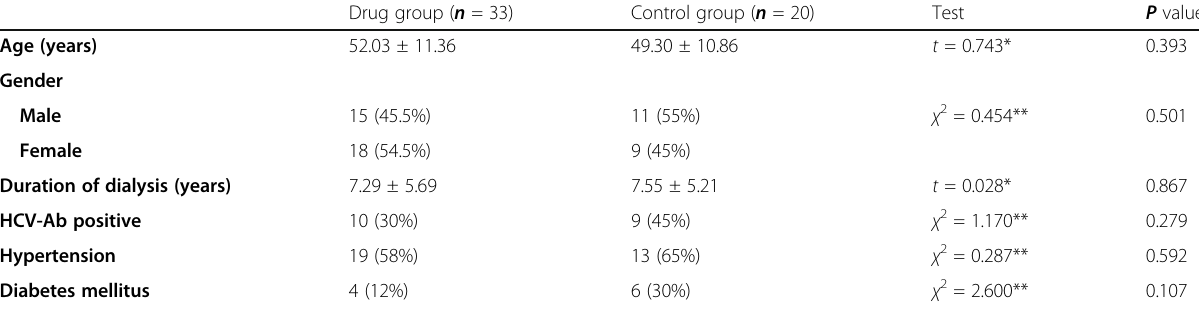
Table 1 Comparison between the drug and control groups as regards the demographic data of the enrolled patients at baseline